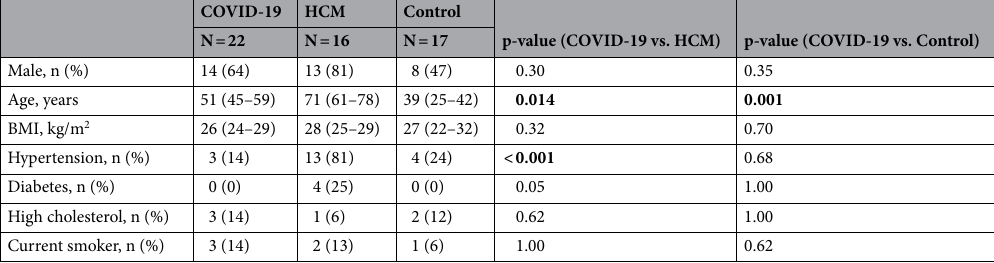
Table 1. Patient characteristics. Bold values indicates p-value <